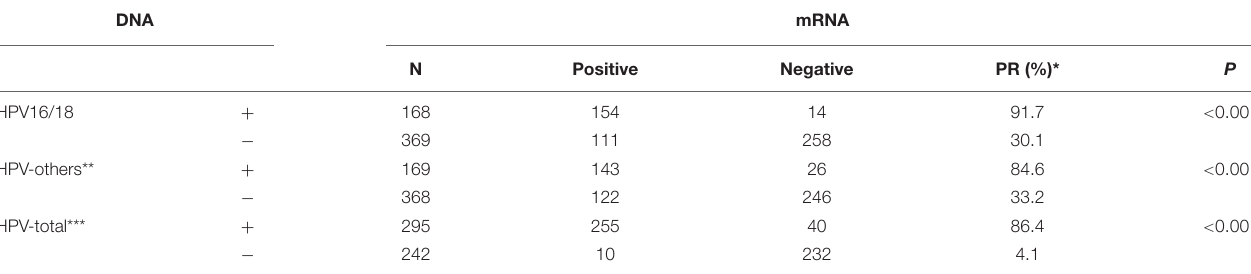
TABLE 1 | The correlation of mRNA and DNA detection by HPV types. DNA